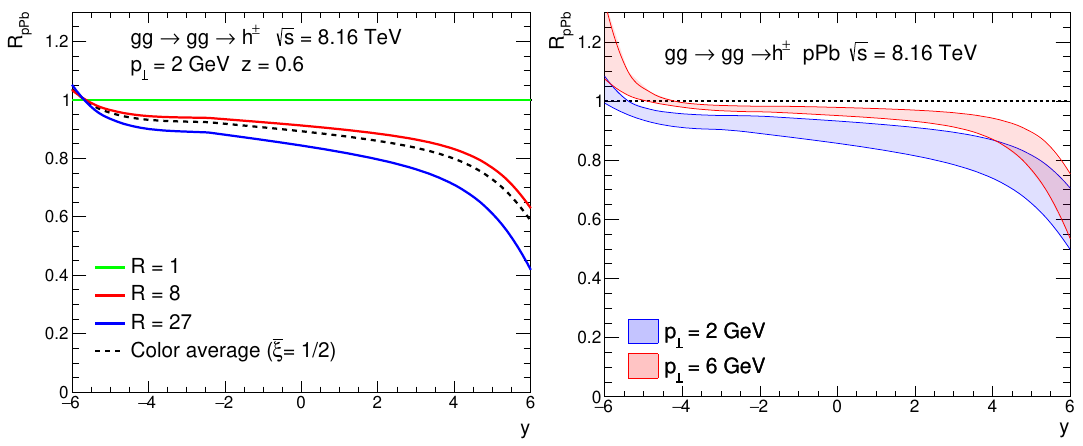
Figure 2 . Left: rapidity dependence of R R for R = 1 (green line), R = 8 (red line), and R = 27 (blue line). The color-averaged nuclear modi(cid:12)cation factor R h function of y and associated uncertainty band, for di(cid:11)erent values of p p s = 8 : 16 TeV in the gg